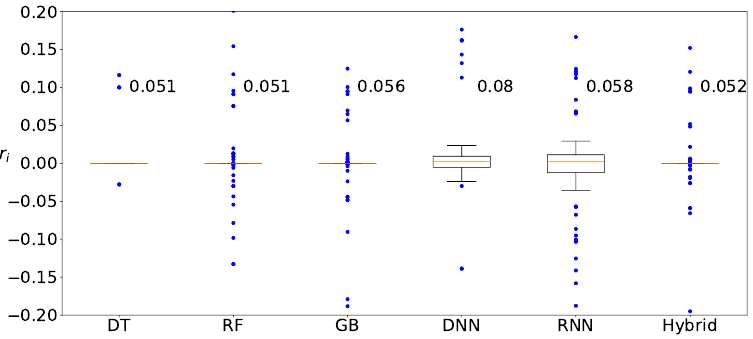
Figure 11. Distribution of predicted values for Zener diodes by using DT, RF, GB, DNN, RNN, and hybrid methods with clustering.